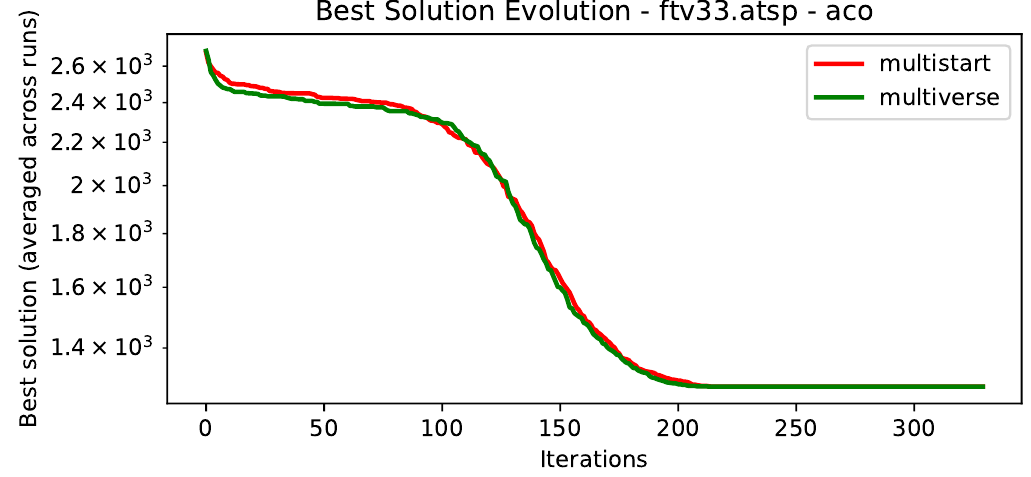
Figure 6. Typical evolution of best Ant Colony Optimization solution versus iteration for Multistart and Multiverse. Each line follows the average of the best solutions across the 25 runs at the corresponding iteration for their respective method. The Y axis is shown in logarithmic